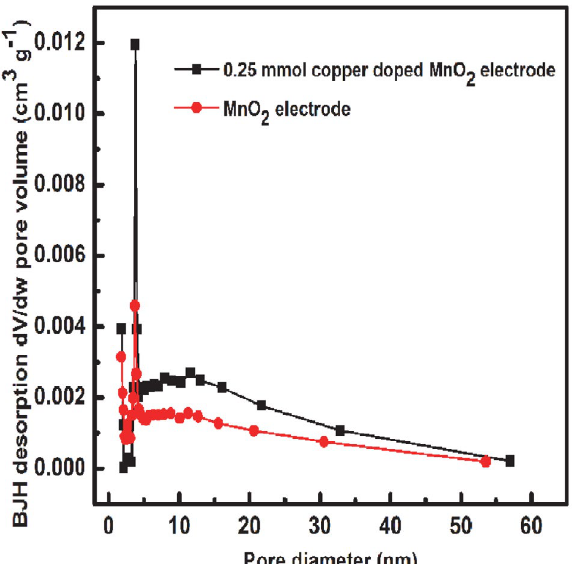
Fig. 4. BJH pore size distribution plot from the desorption branch of the MnO 2 and 0.25 mmol Cu 2+ doped MnO 2 electrode.